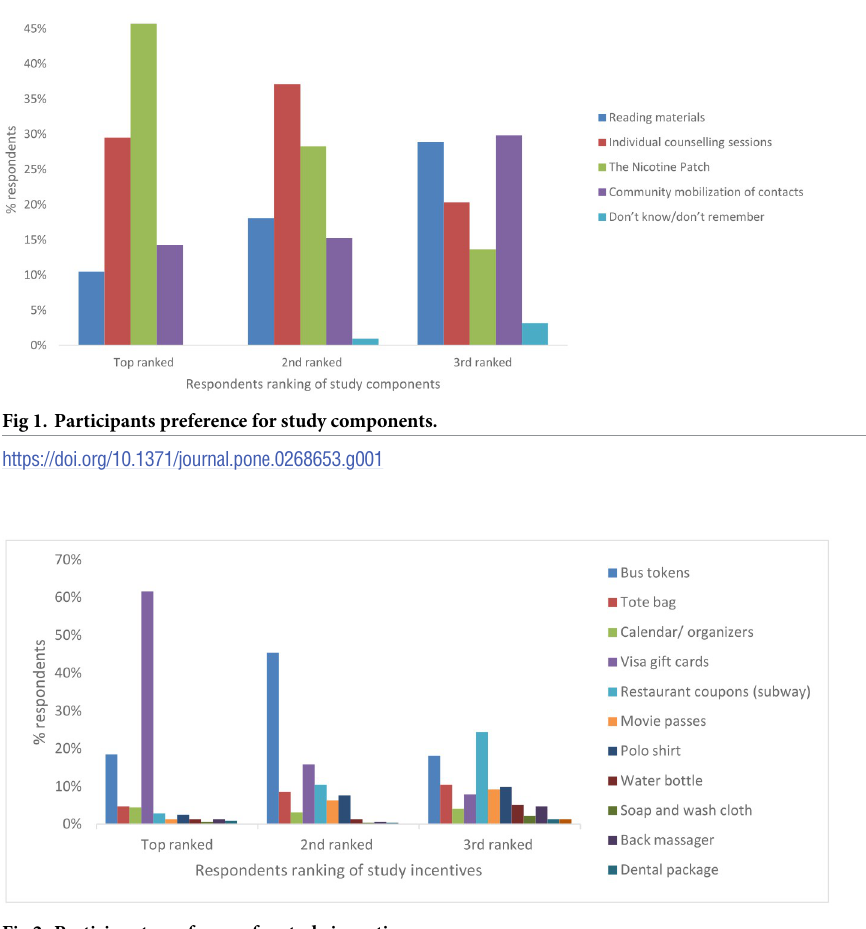
Fig 2. Participants preference for study